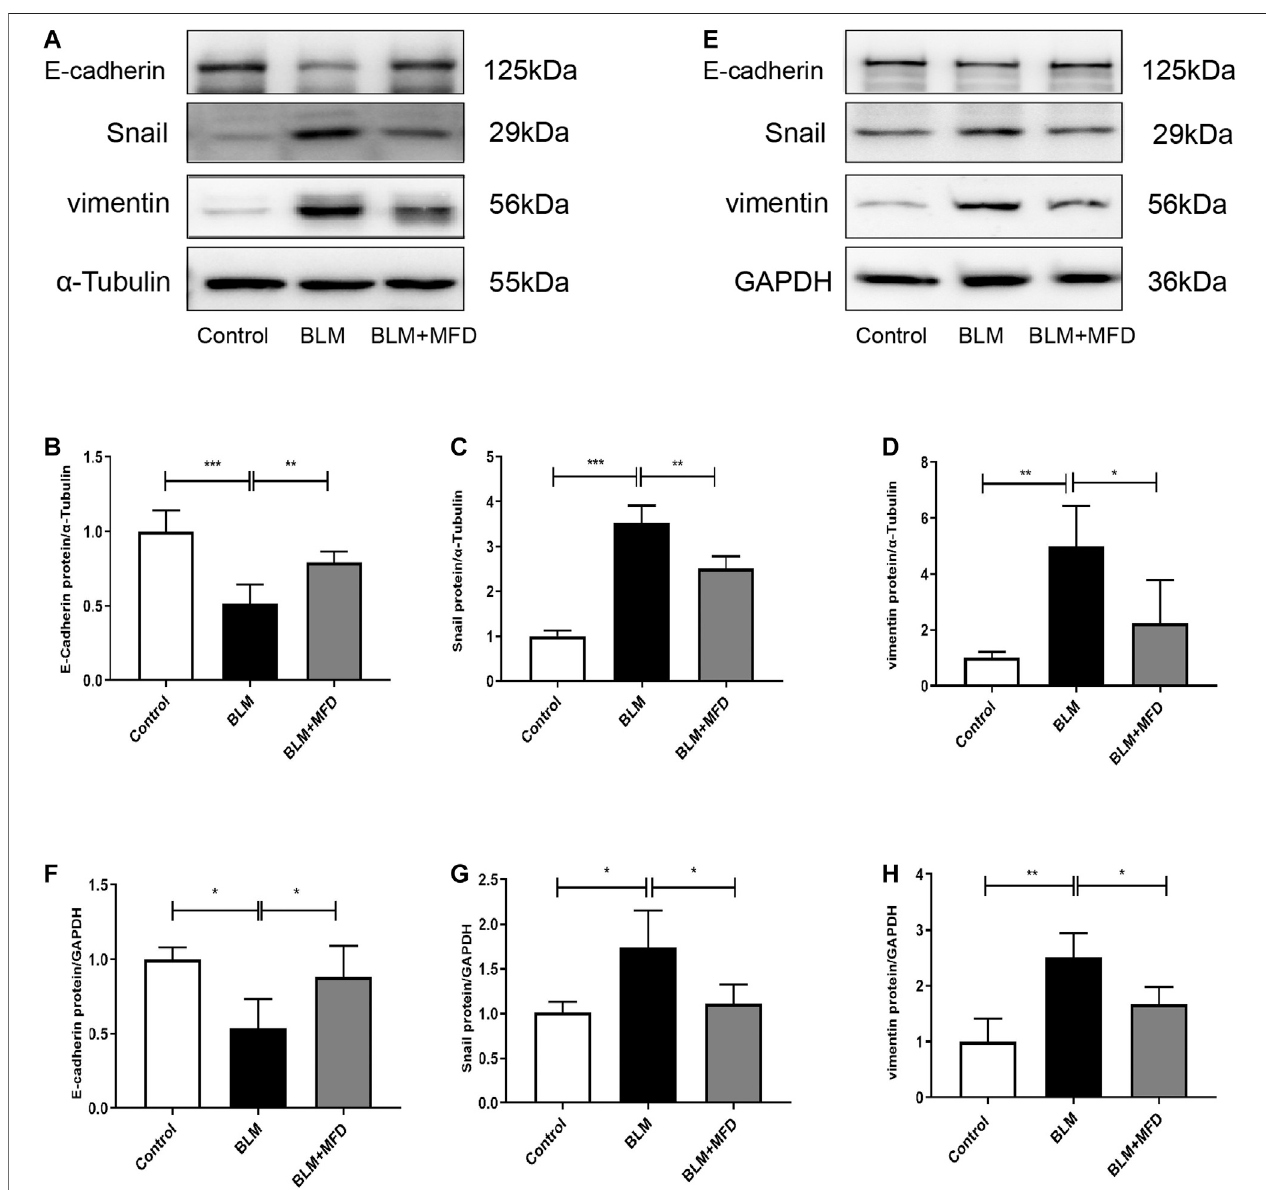
FIGURE 7 | Mefunidone inhibited epithelial-to-mesenchymal transition both in vivo and in vitro (A – D) : Western blotting (A) and quantitative analysis of E-cadherin (B) , Snail (C) and vimentin (D) in lung tissues from different groups (E – H) : Western blotting (E) and quantitative analysis of E-cadherin (F) , Snail (G) and vimentin (H) in MLE-12 cells treated with bleomycin (400 μ g/ml) with/without mefunidone (40 μ g/ml) pretreatment. All experiments were conducted with more than three independent replications. Data were presented as mean ± SD. ANOVA was used for comparison in (B – D) and (F – H) . * p < 0.05; ** p < 0.01; *** p < 0.001.